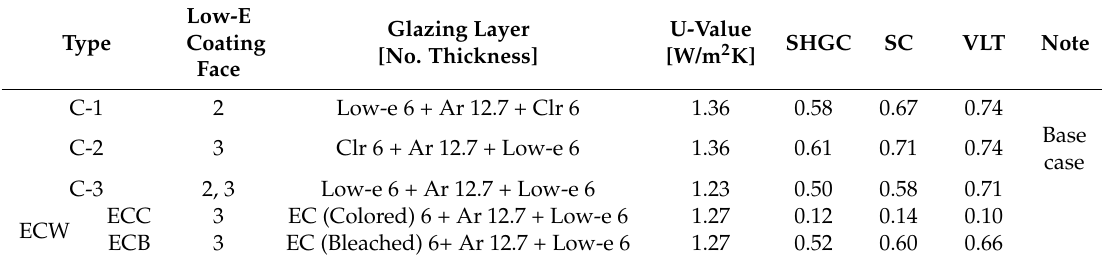
Table 3. Physical properties of exterior window.